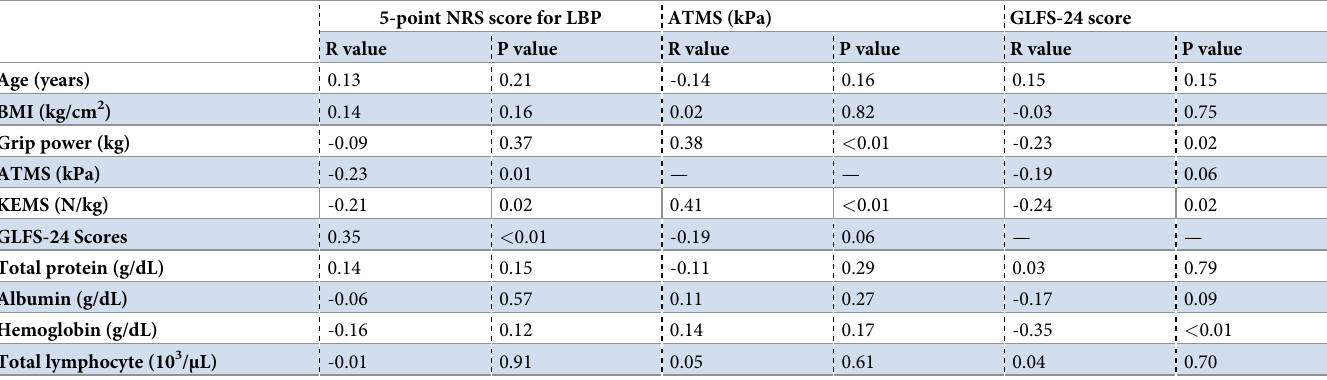
Table 4. Correlation with the degrees of LBP, abdominal trunk muscle strength, and locomotive syndrome among all 101